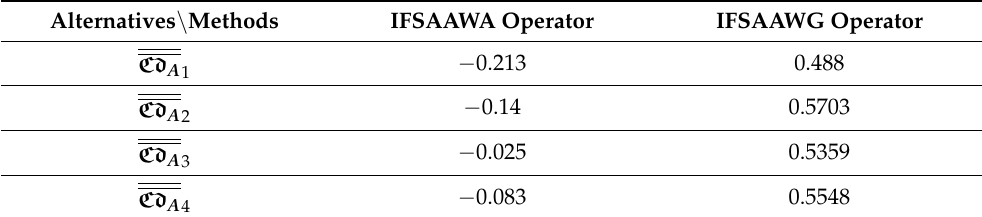
Table 6. Representation of score values.